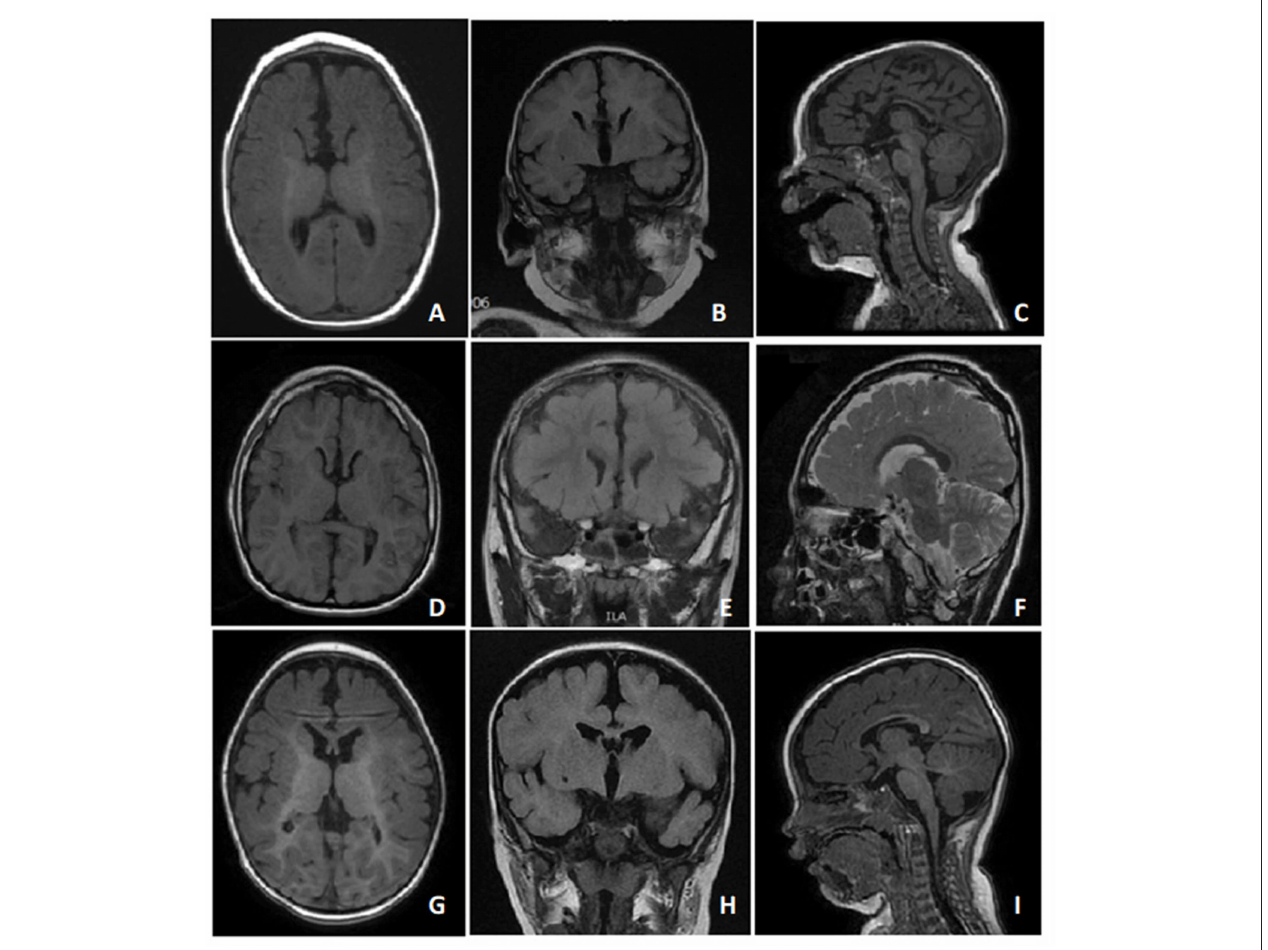
FIGURE 2 | T1 and T2 MRI images of case 1 (A-C) at 6 months of age, case 2 (D-F) at 7 years of age, and case 3 (G-I) at 11 months of age showed dysgenesis of the corpus callosum, including the genu and body portions of the corpus